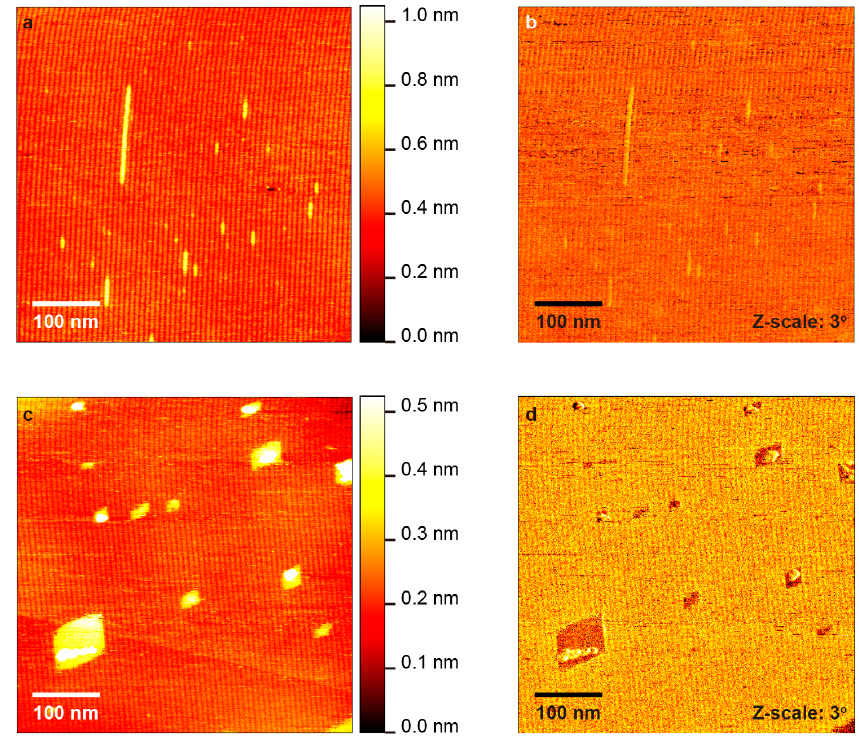
Figure 2. AFM topography ( a ); and phase shift ( b ) of diacetylene on hexagonal-Boron Nitride (h-BN) after 5 s of UV irradiation; and the same sample after additional 5 s of irradiation (10 s in total) ( c ) topography; ( d ) phase shift.